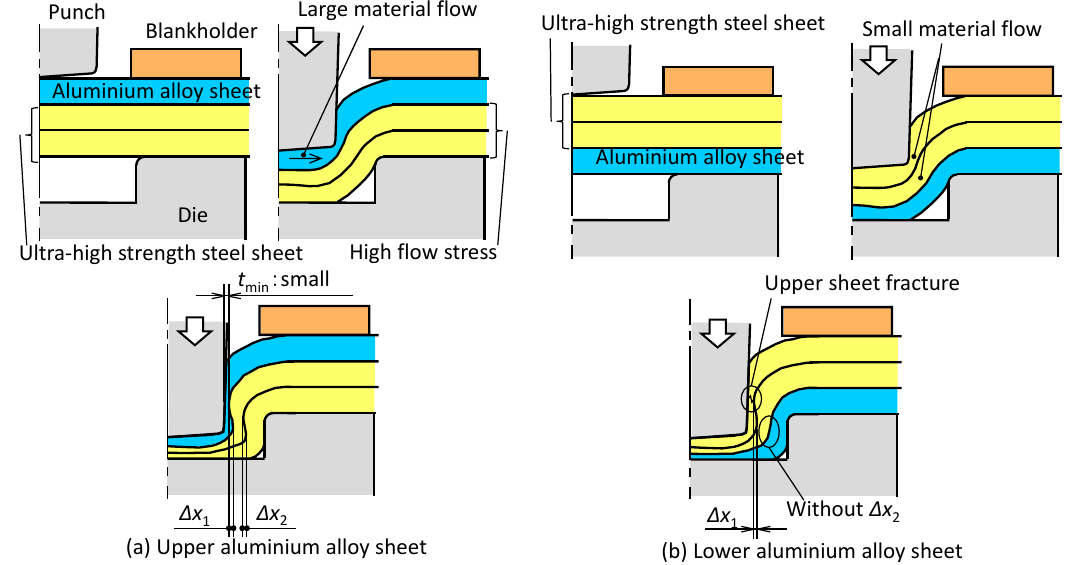
Figure 15. Effects of sheet combinations on the deforming behavior of sheets: ( a ) upper aluminium alloy sheet; ( b ) lower aluminium alloy sheet.